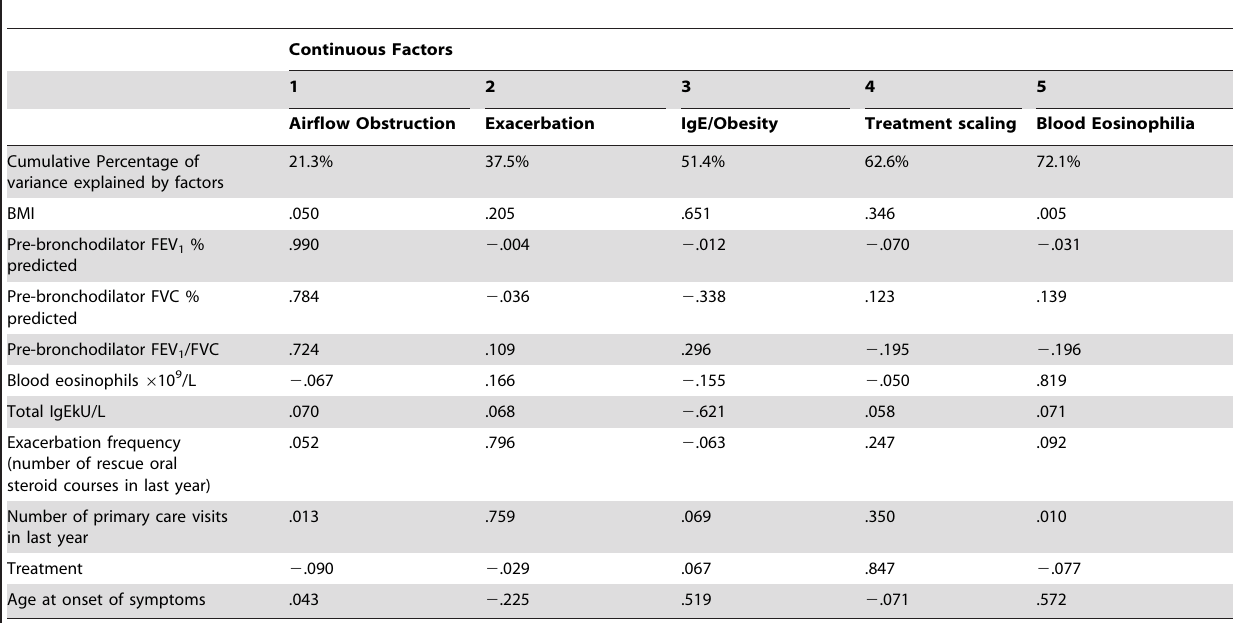
Table 1. Factor loading for continuous variables from first imputed data set, other factor analysis on the other 4 imputed datasets showed similar structure and factor